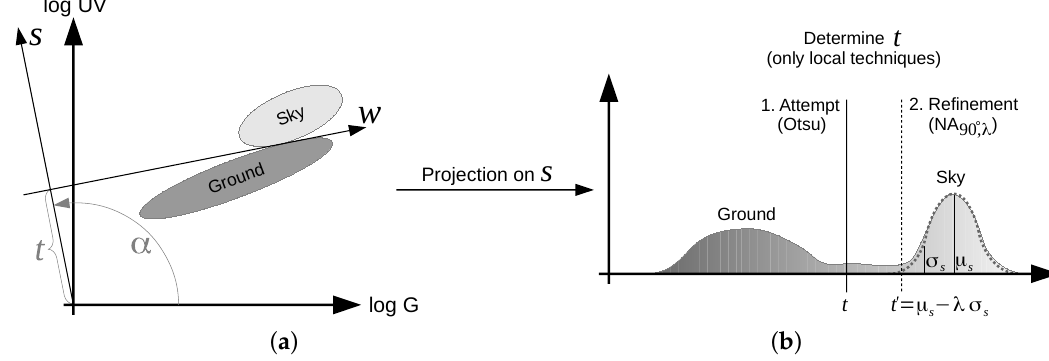
Figure 8. ( a ) (projection): Global and local separation techniques project the log UV/G data onto a hyperplane s with angle α . The angle α is always fixed for all global separation techniques, as well as the local technique NA α , λ . ( b ) (threshold selection): While the threshold value t is learned from a large set of training images for global separation techniques, local separation techniques learn it for each input image pair (log UV and log G) individually. Local separation techniques maximize Otsu’s criterion by iterating the threshold values t . Furthermore, the technique NA α , λ approximates a normal distribution N ( µ , σ ) to the sky class (based on the threshold t ) and refines the threshold value based on this distribution as t (cid:48) = µ − λσ , where λ is a correction